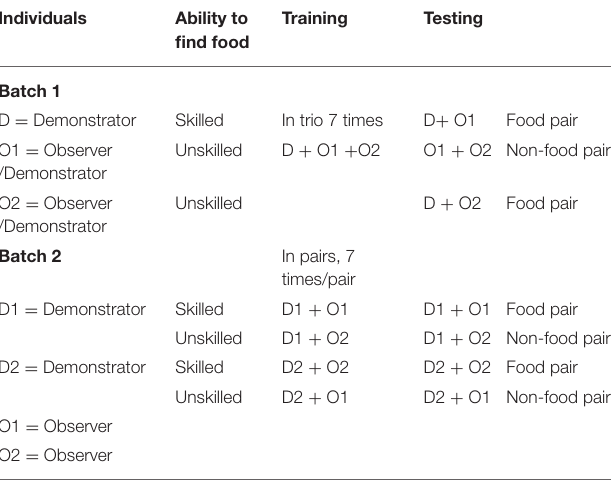
TABLE 1 | Overview of the roles of the individuals and how they were combined in the training and testing sessions in batch 1 and 2. Individuals Ability to Training find food